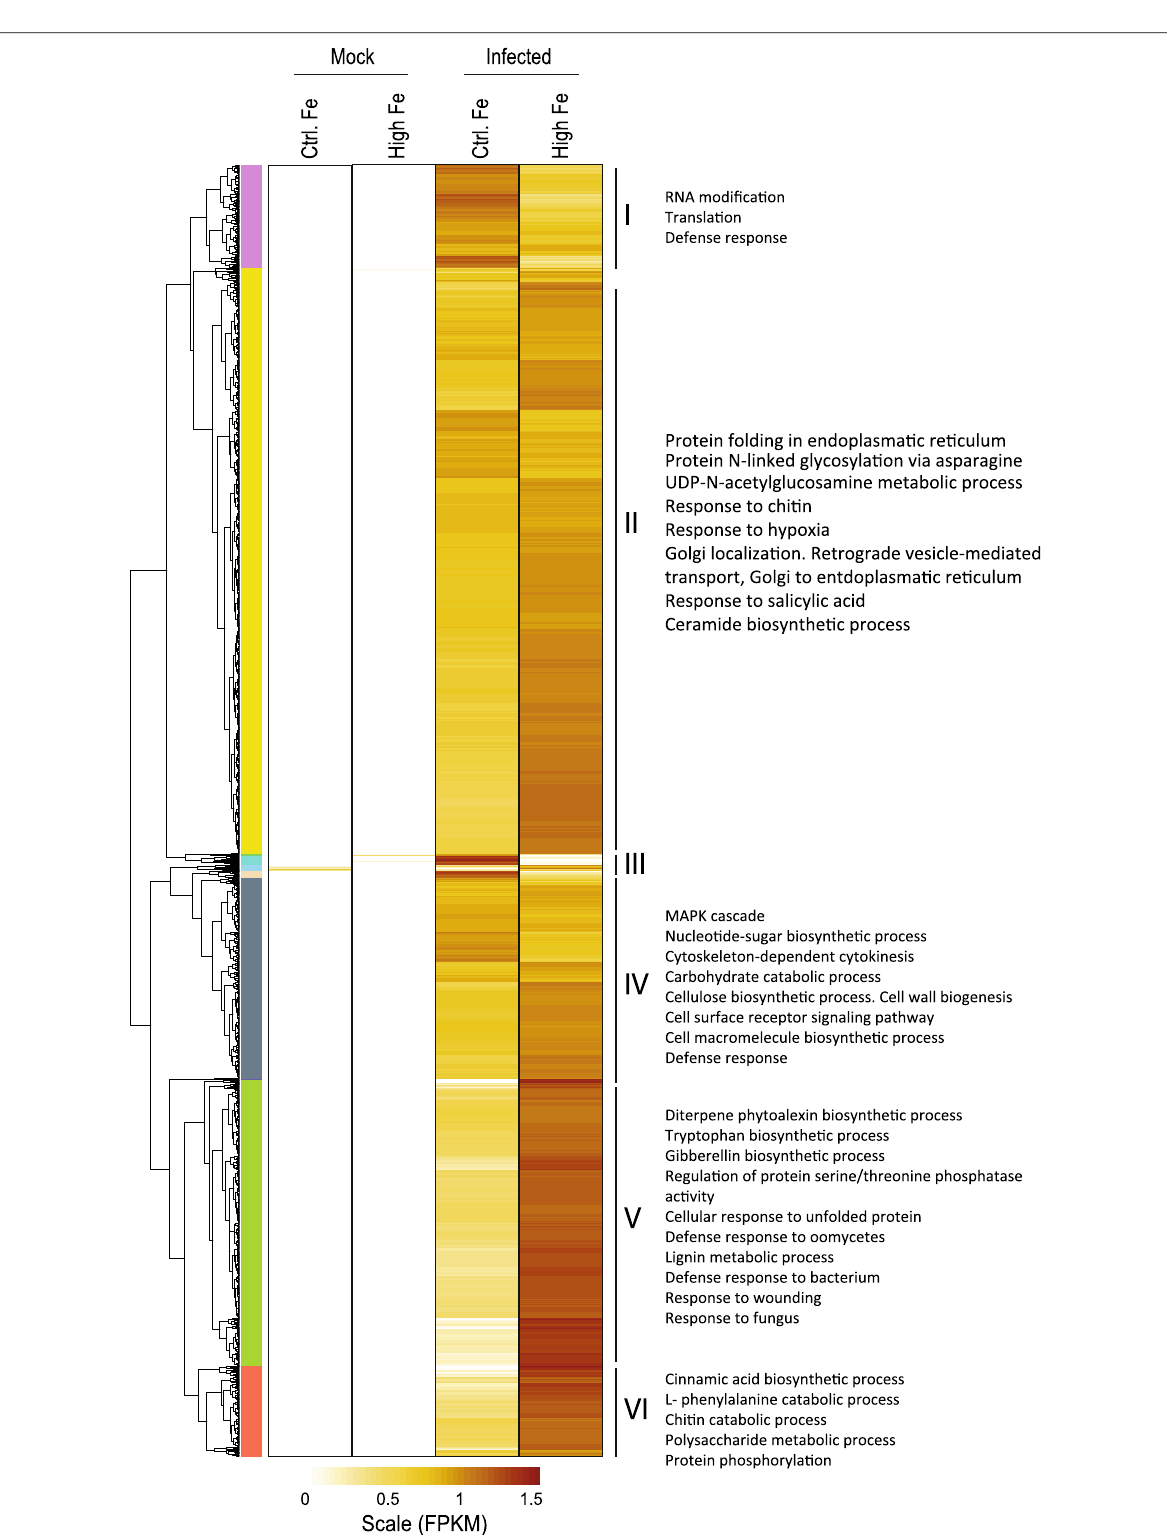
Fig. 4 Hierarchical clustering of genes that are regulated by M. oryzae infection in Control and High‑Fe plants. The expression level is depicted as row scaled FPKM (fragments per kilobase per million reads) and is represented from pale yellow (less expressed) to brown (more expressed). GO enrichment analyses of DEGs in each individual cluster revealed over‑represented GO terms (shown on the